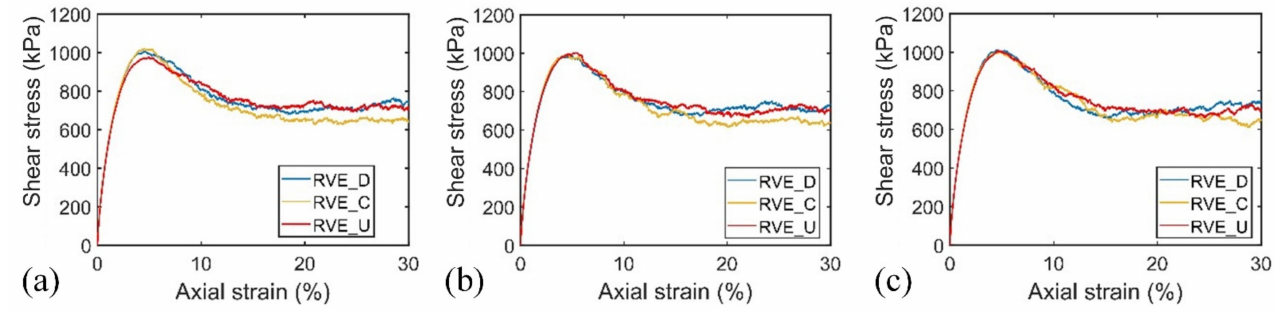
Figure 15. Stress–strain behavior for the specimen FC60 at t = ( a ) 0.0 s; ( b ) 0.1 s; and ( c ) 0.2